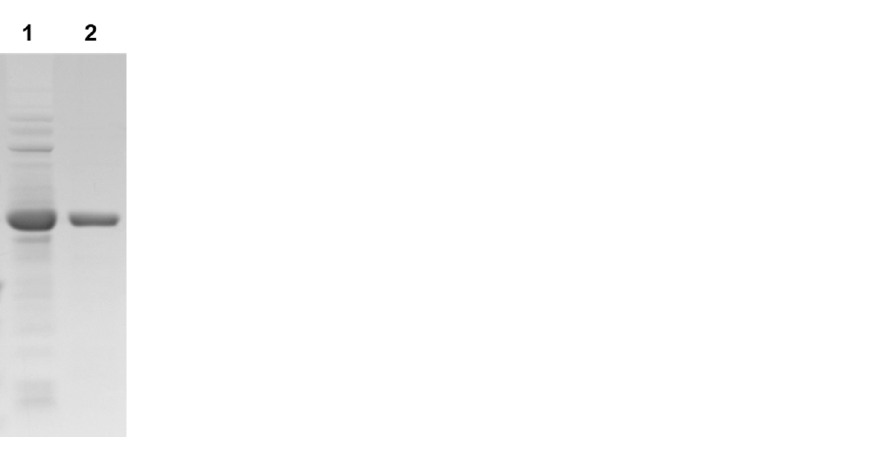
Figure 3. Sodium dodecyl sulfate-polyacrylamide gel electrophoresis (SDS-PAGE) of the purified rXylR after affinity chromatography on HisTrap HP. Lane S, standard marker proteins; lane 1, the soluble cell lysate of rXylR-expressing E. coli BL21 after IPTG induction; lane 2, purified rXylR.